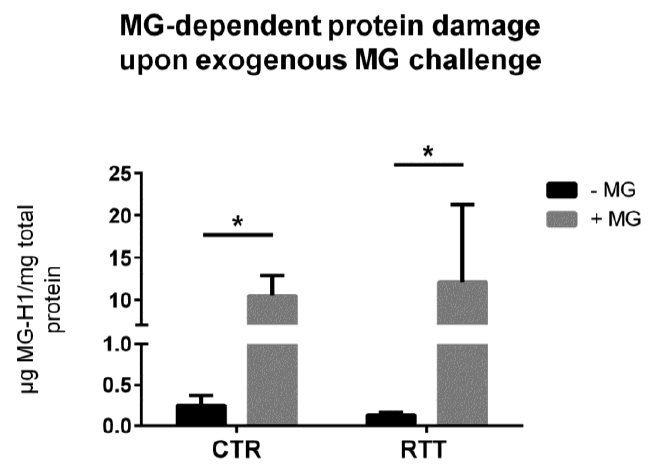
Figure 4. Assessment of methylglyoxal-derived hydroimidazolone 1 (MG-H1) levels, following a 24 h exogenous MG challenge. Data were given as means ± SD. CTR, control; RTT, Rett syndrome; MG, methylglyoxal. * p < 0.05. Results were analyzed by two-way ANOVA, with post hoc Tukey’s multiple comparisons test.